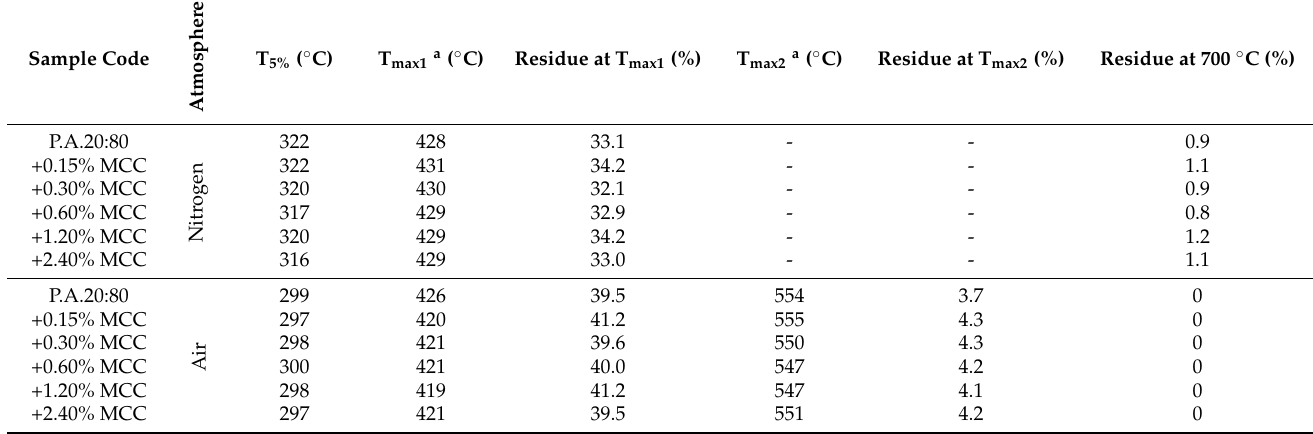
Table 6. Thermogravimetric data for MCC-based composites.